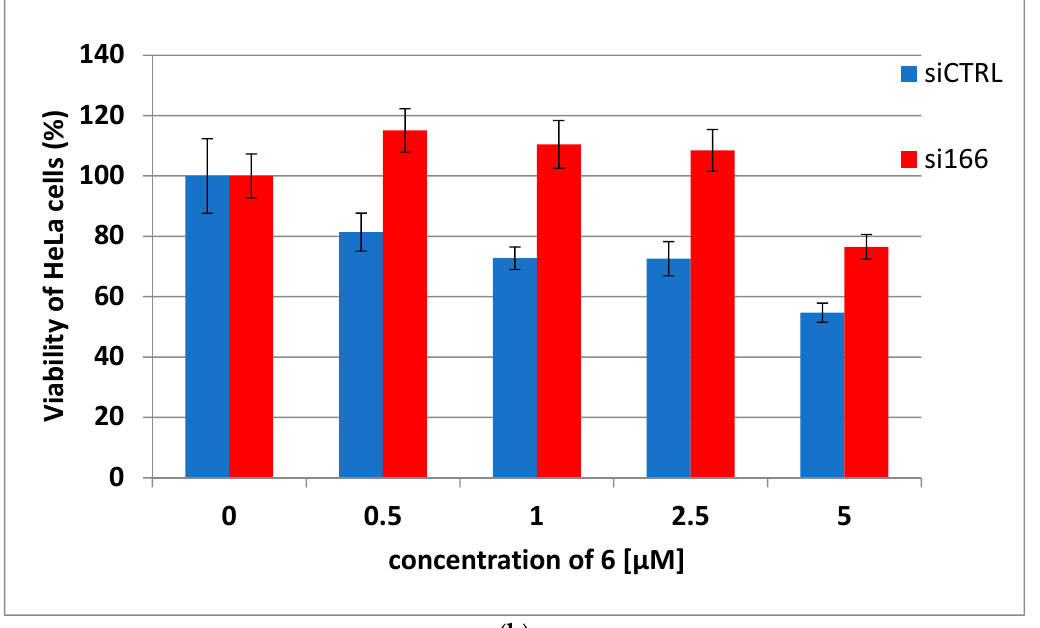
Figure 6. ( a ) Downregulation of ABC50 by siRNA. HeLa cells were transfected with a 100 nM of siRNA. 48 h posttransfection ABC50 levels were determined by Western blotting. ABC50 level in